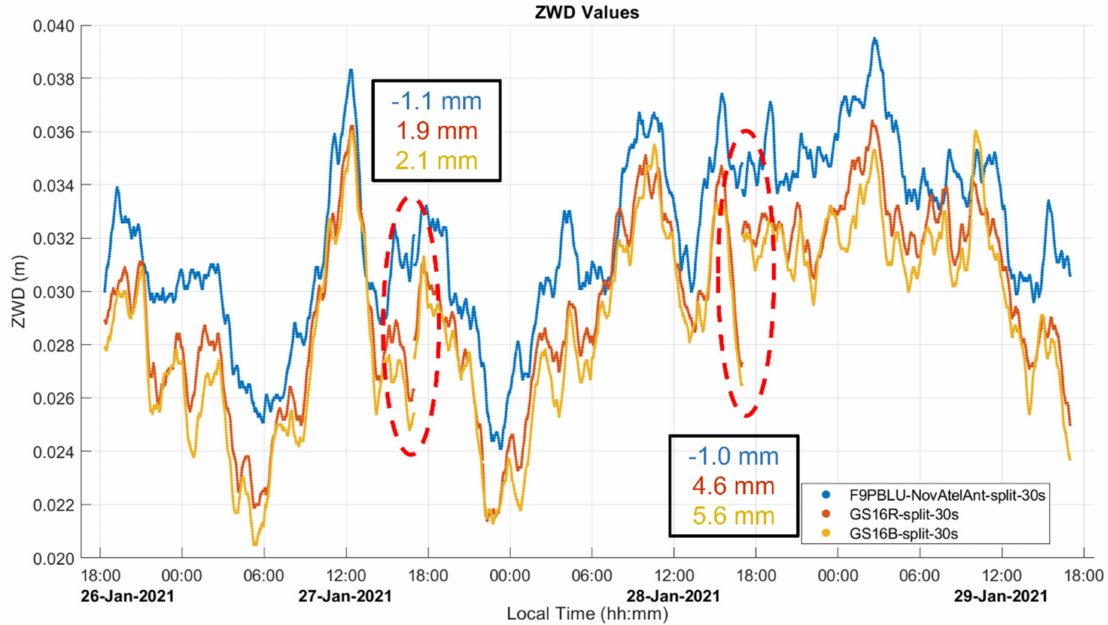
Figure 10. Static Dataset A ZWD profiles split into 24 h segments and differences at the two junction points. Local time is UTC −